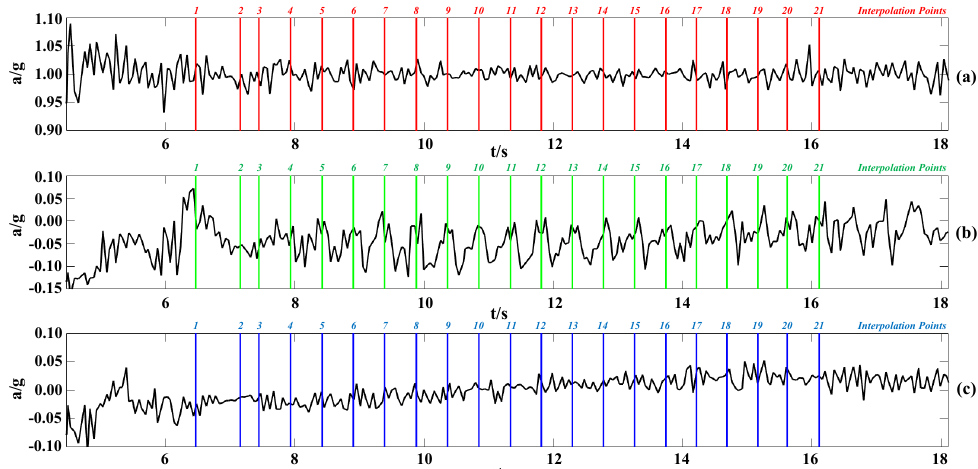
Figure 7. Temporal correspondence between the interpolation points and the acceleration changes at the robotic arm’s end. ( a ) The correspondence of the X axis. The red line indicates the relative time of the interpolated points. ( b ) The correspondence of the Y axis. The green line indicates the relative time of the interpolated points. ( c ) The correspondence of the Z axis. The blue line indicates the relative time of the interpolated